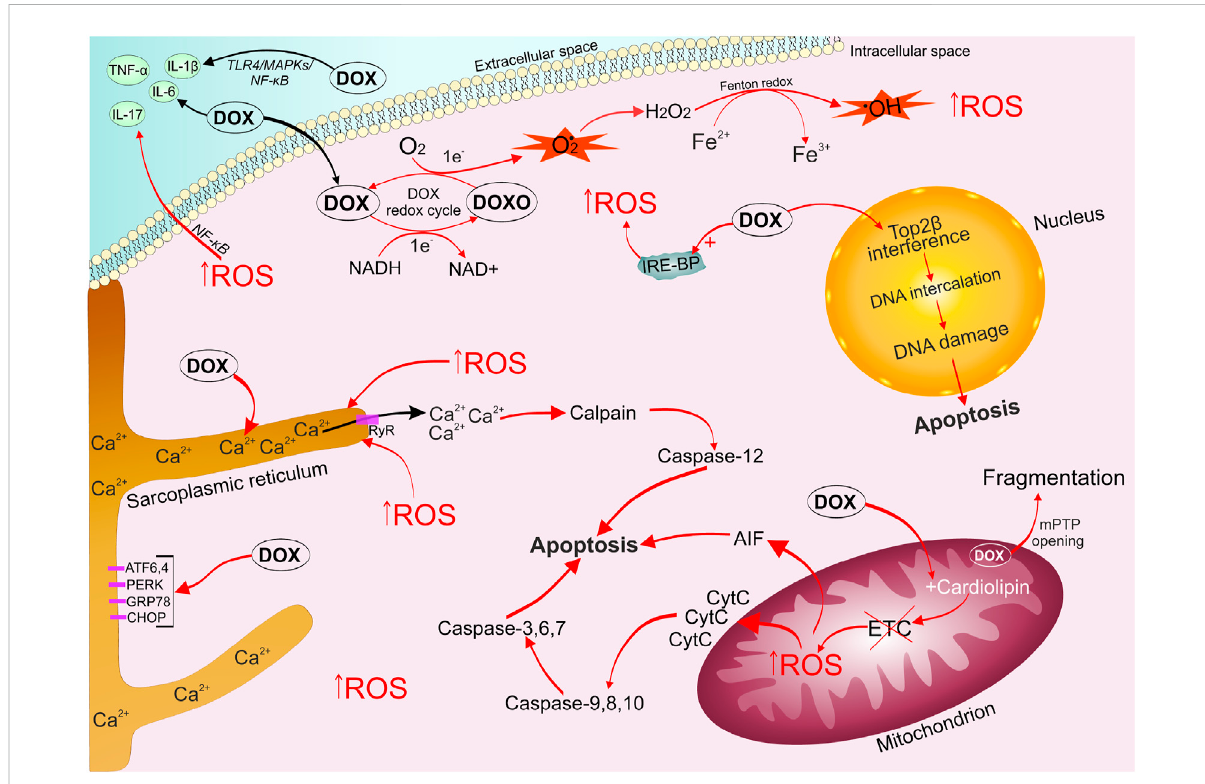
FIGURE 1 Mechanisms of doxorubicin-induced cardiomyopathy development. DOX is easily captured by cells, it undergoes one-electron reduction with theformationofasuperoxideradical.Thealternationofquinone andsemiquinoneDOXstructurestriggersthegenerationofalargeamountofROS. DOXleadstodisruptionoftheelectrontransportchain, whichtriggersmitochondrialsignaling pathwaysofapoptosis. Theemergingoxidativestress causes an imbalance of calcium ions in the sarcoplasmic reticulum, the opening of mPTP, which ultimately activates the work of apototic caspases. DOX stimulates the accumulation of unutilized free iron in the cell, by binding to intracellular iron sequestration proteins, which enhances theROS formation cycle.DOXandoxidativestresscontributeincreased production ofin fl ammatoryfactors((IL-1 β ),IL-6, IL-17,TNF- α ) via activation of (TLR4)/MAPKs/NF- κ B pathways. DOX, captured by the cell nucleus, binds to Top2 β , forming a triple DOX-Top2 β -DNA complex, which inhibits DNA replication, stops the cell cycle in G1 / G2 and initiates programmed cell death. ATF6/4, activating transcription factor 6/4; CHOP, C/EBP homologous protein; DOX, doxorubicin; DOXO, semiquinone form of doxorubicin; ETC, electron transport chain; GRP78, 78-kDa glucose- regulated protein precursor; IL-6/17/1 β , interleukin 6/17/1 β ; IRE-BP, iron-responsive element-binding proteins; MAPKs, mitogen-activated protein kinases; mPTP, mitochondrial permeability transition pore; NF- κ B, nuclear factor kappa-light-chain-enhancer of activated B cells; PERK, (PKR)-like endoplasmic reticulum kinase; ROS, reactive oxygen species; TLR4, toll-like receptor 4; TNF- α , tumor necrosis factor; Top2 β , topoisomerase 2 β